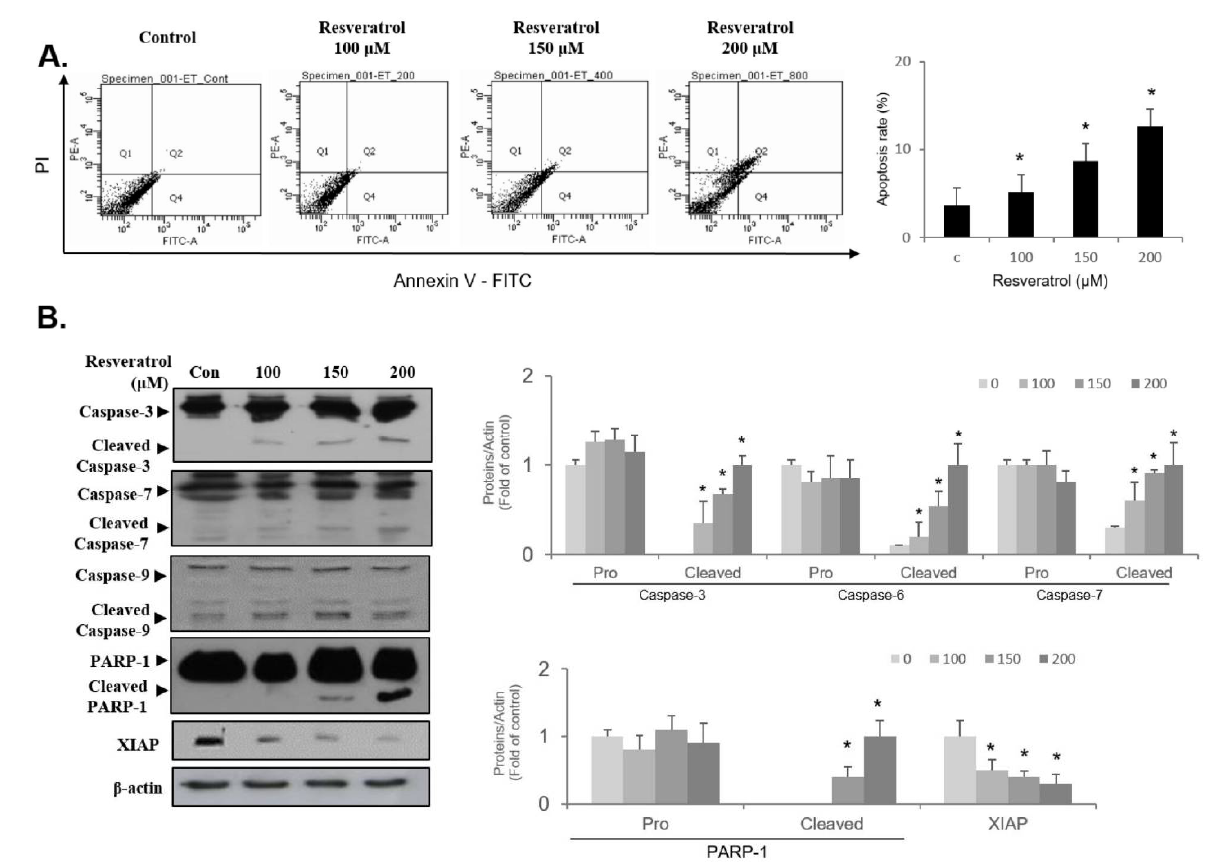
Figure 8. Apoptosis induction in resveratrol-treated WPMY-1 cells. Cells were incubated with various concentrations of resveratrol for 24 h. ( A ) FACS analyses were performed to examine the apoptotic cell death using propidium iodide and annexin V staining. The percentage of apoptotic cells were determined by bar graph compared to controls. ( B ) Changes levels of apoptosis-related regulators in resveratrol-treated WPMY-1 cells were analyzed by immunoblotting. Loading control was presented as β-actin. Bar graphs are given as relative fold changes of each protein in comparison to the control group. Values are expressed as the mean ± SD of three independent experiments; * p < 0.05 compared with the control group.